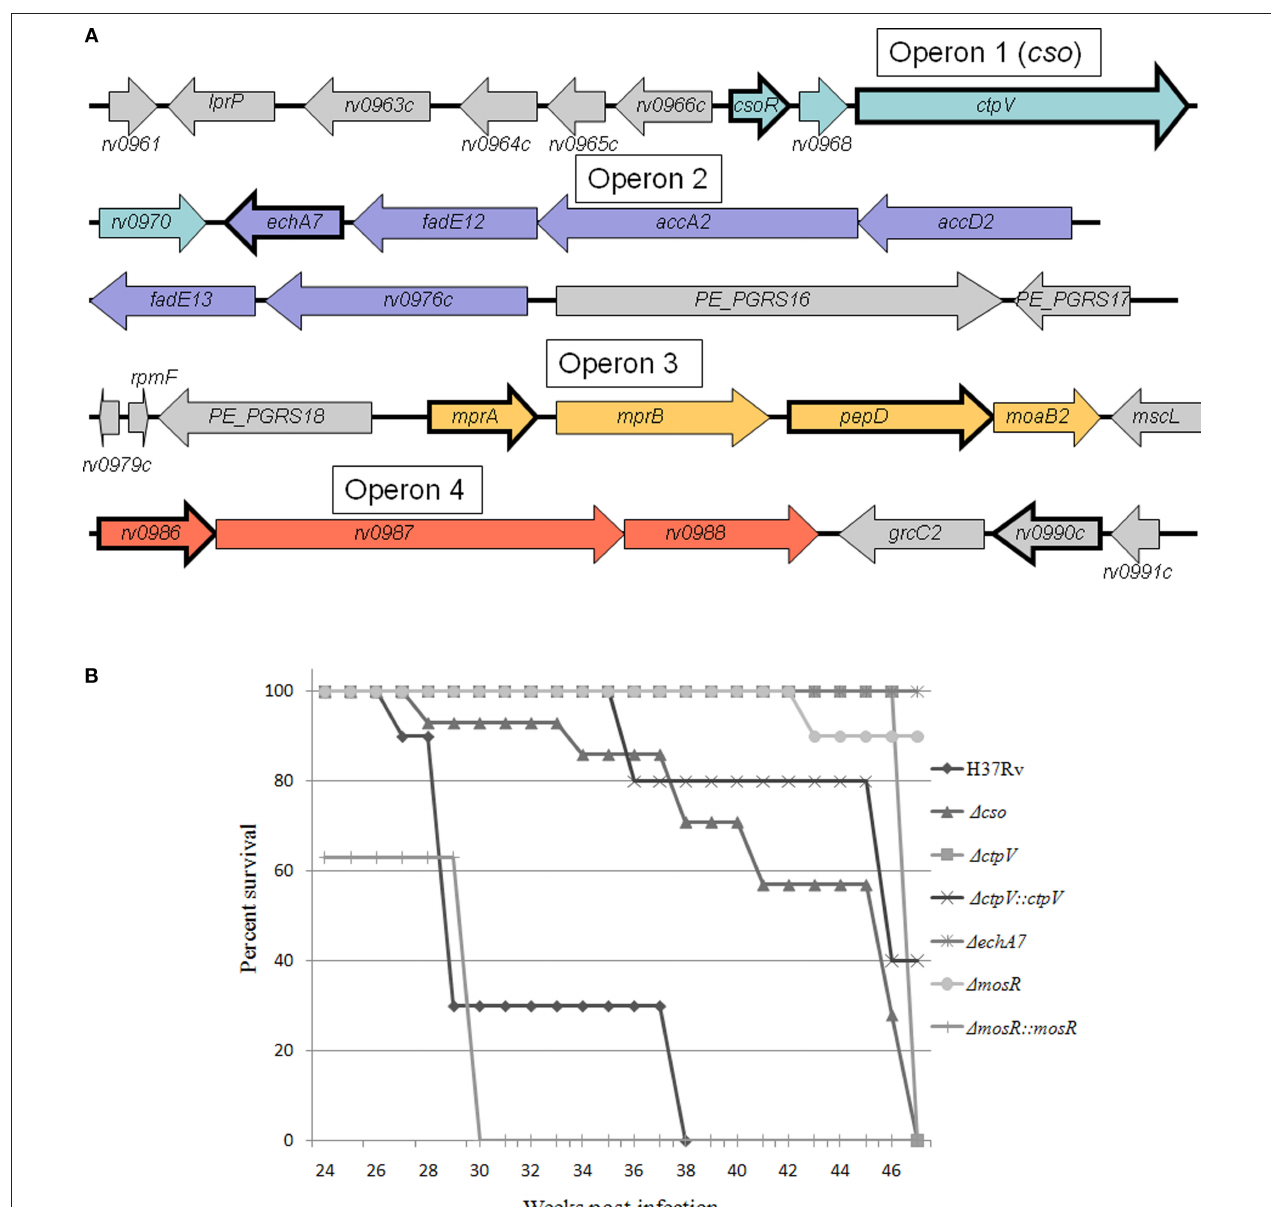
wild-type strain (H37Rv), or with targeted deletion strains created based on in vivo transcriptional profiling. Mouse groups were infected using aerosol infection (Glas-col inhalation system) using 100–300 CFU/animal (Abomoelak et al., 2009). The survival of infected mice was monitored over the course of a 1-year